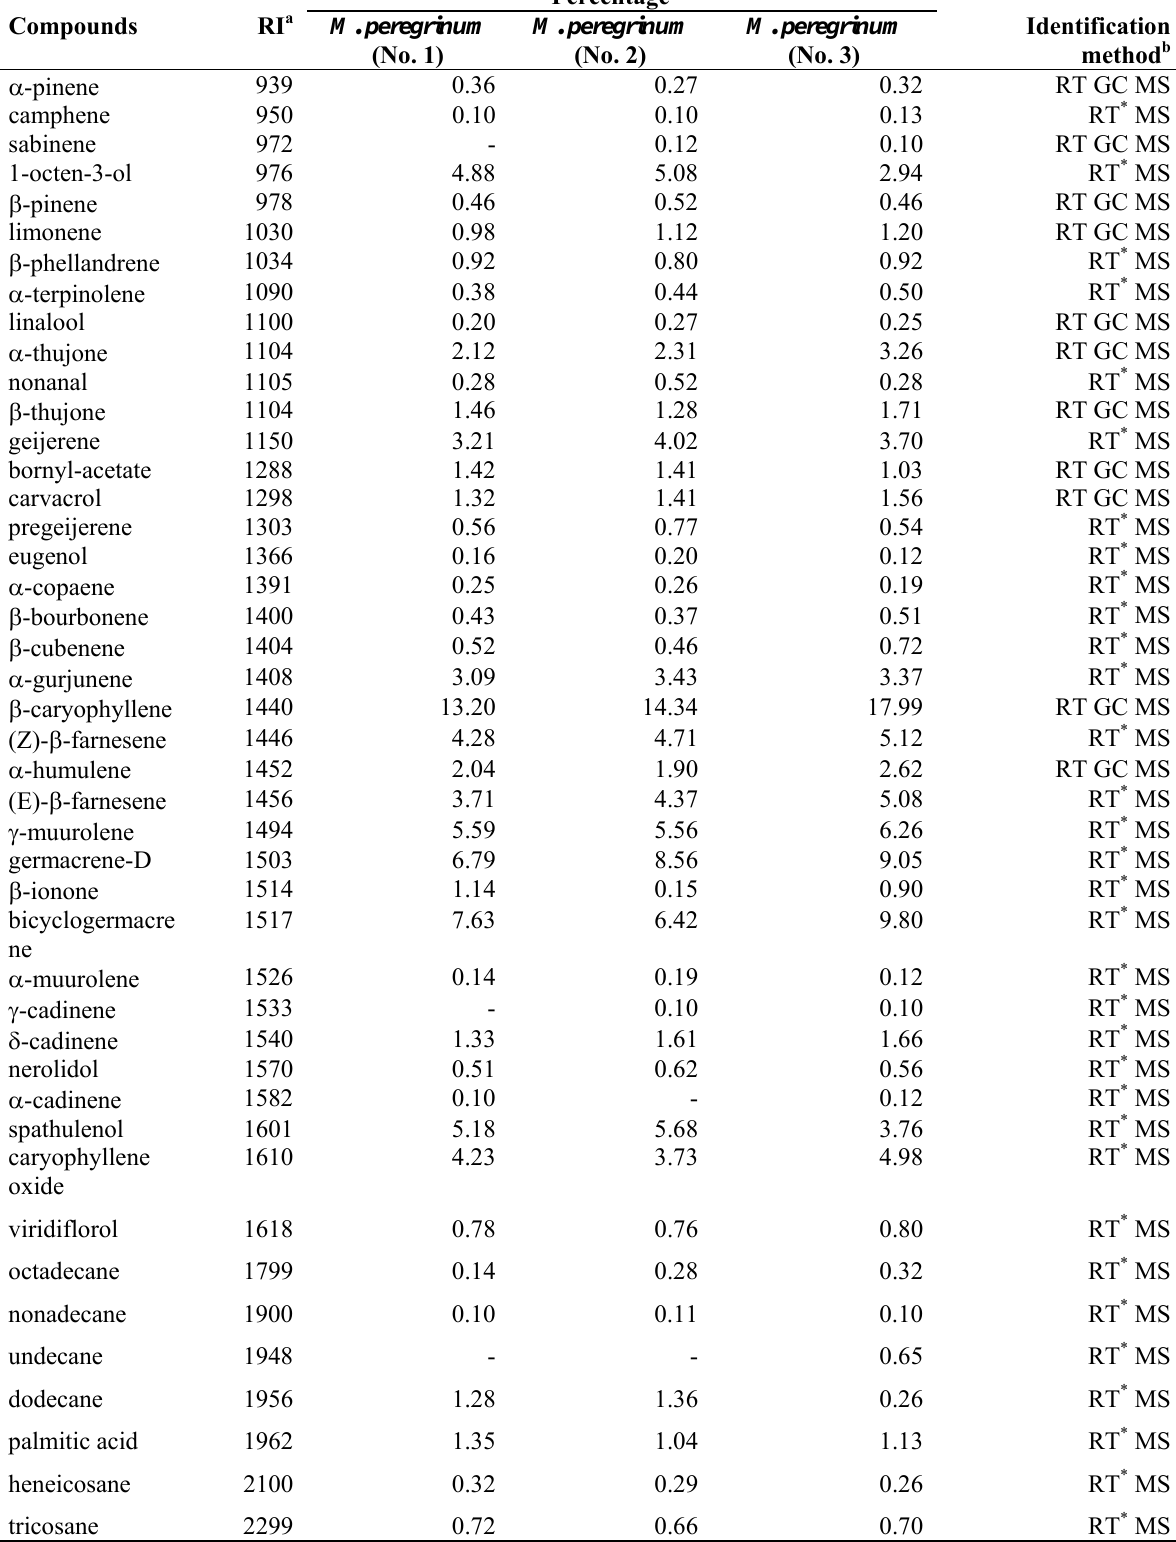
Table 1. Chemical composition of Marrubium peregrinum essential oil.